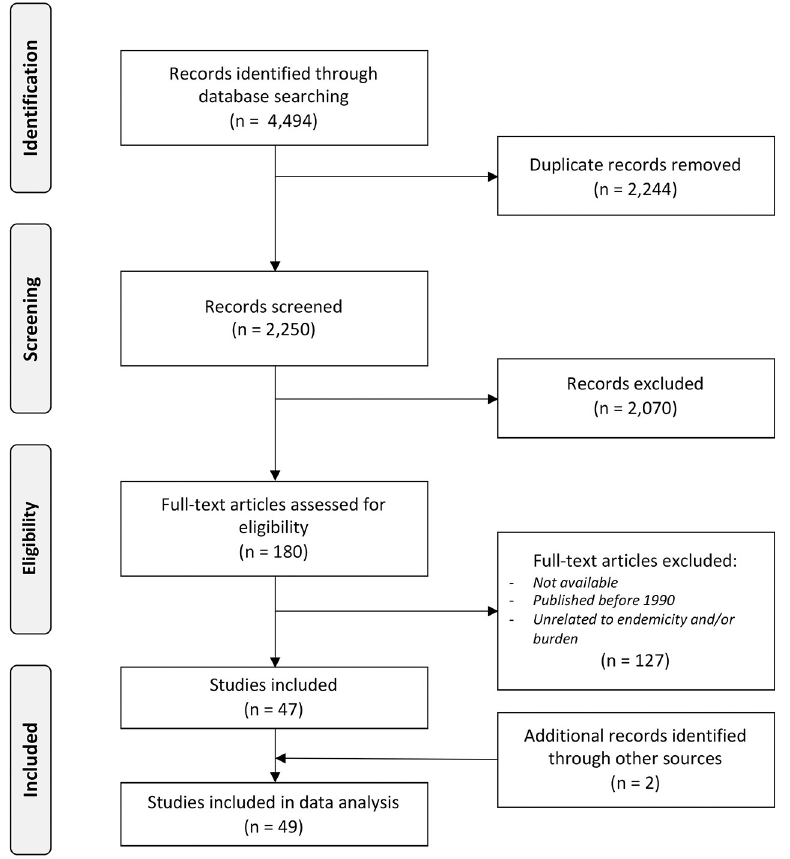
Fig 1. PRISMA Flow Diagram of systematic literature